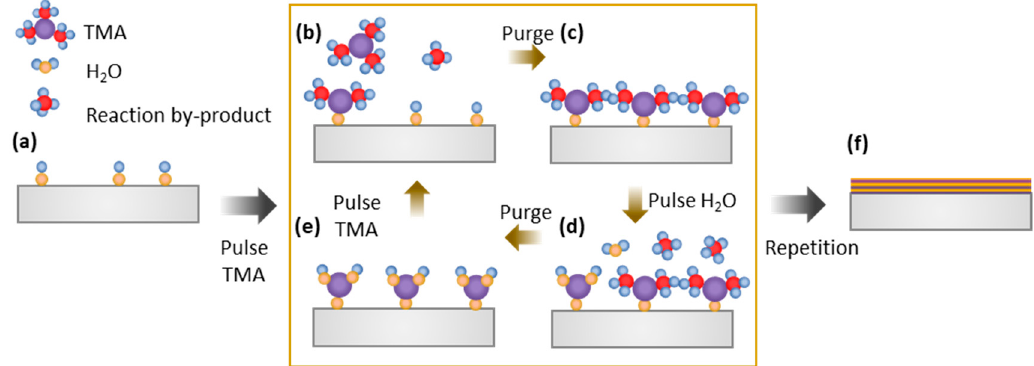
Figure 13. Schematic representation of an AB-type ALD process, illustrated for the deposition of Al 2 O 3 films on a SiO 2 substrate using a TMA/H 2 O ALD process. ( a ) SiO 2 substrate surface with OH groups. ( b ) Pulsing vapor-phase TMA leads to a first surface reaction, with by-product formation. ( c ) When the surface is saturated, excess TMA and by-products are purged out. ( d ) The second reactant, H 2 O vapor, is pulsed and the second surface reaction takes place. ( e ) The substrate surface is saturated with H 2 O; a first alumina (sub-)monolayer is formed and H 2 O and by-products are purged. ( f ) Steps b–e are repeated to form an alumina film with the desired thickness. Grey: SiO 2 substrate; orange sphere: oxygen atom; blue sphere: hydrogen atom; red sphere: carbon atom; purple sphere: aluminum atom.